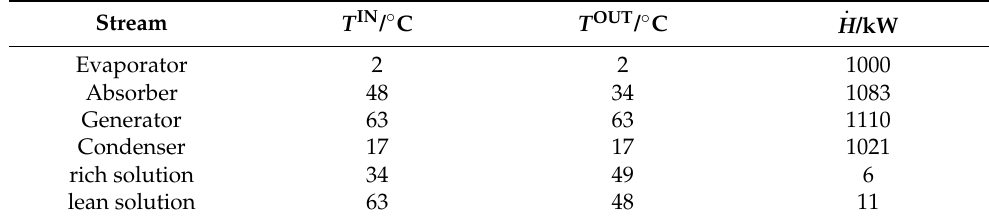
Table 3. Derived streams from the AC for case study